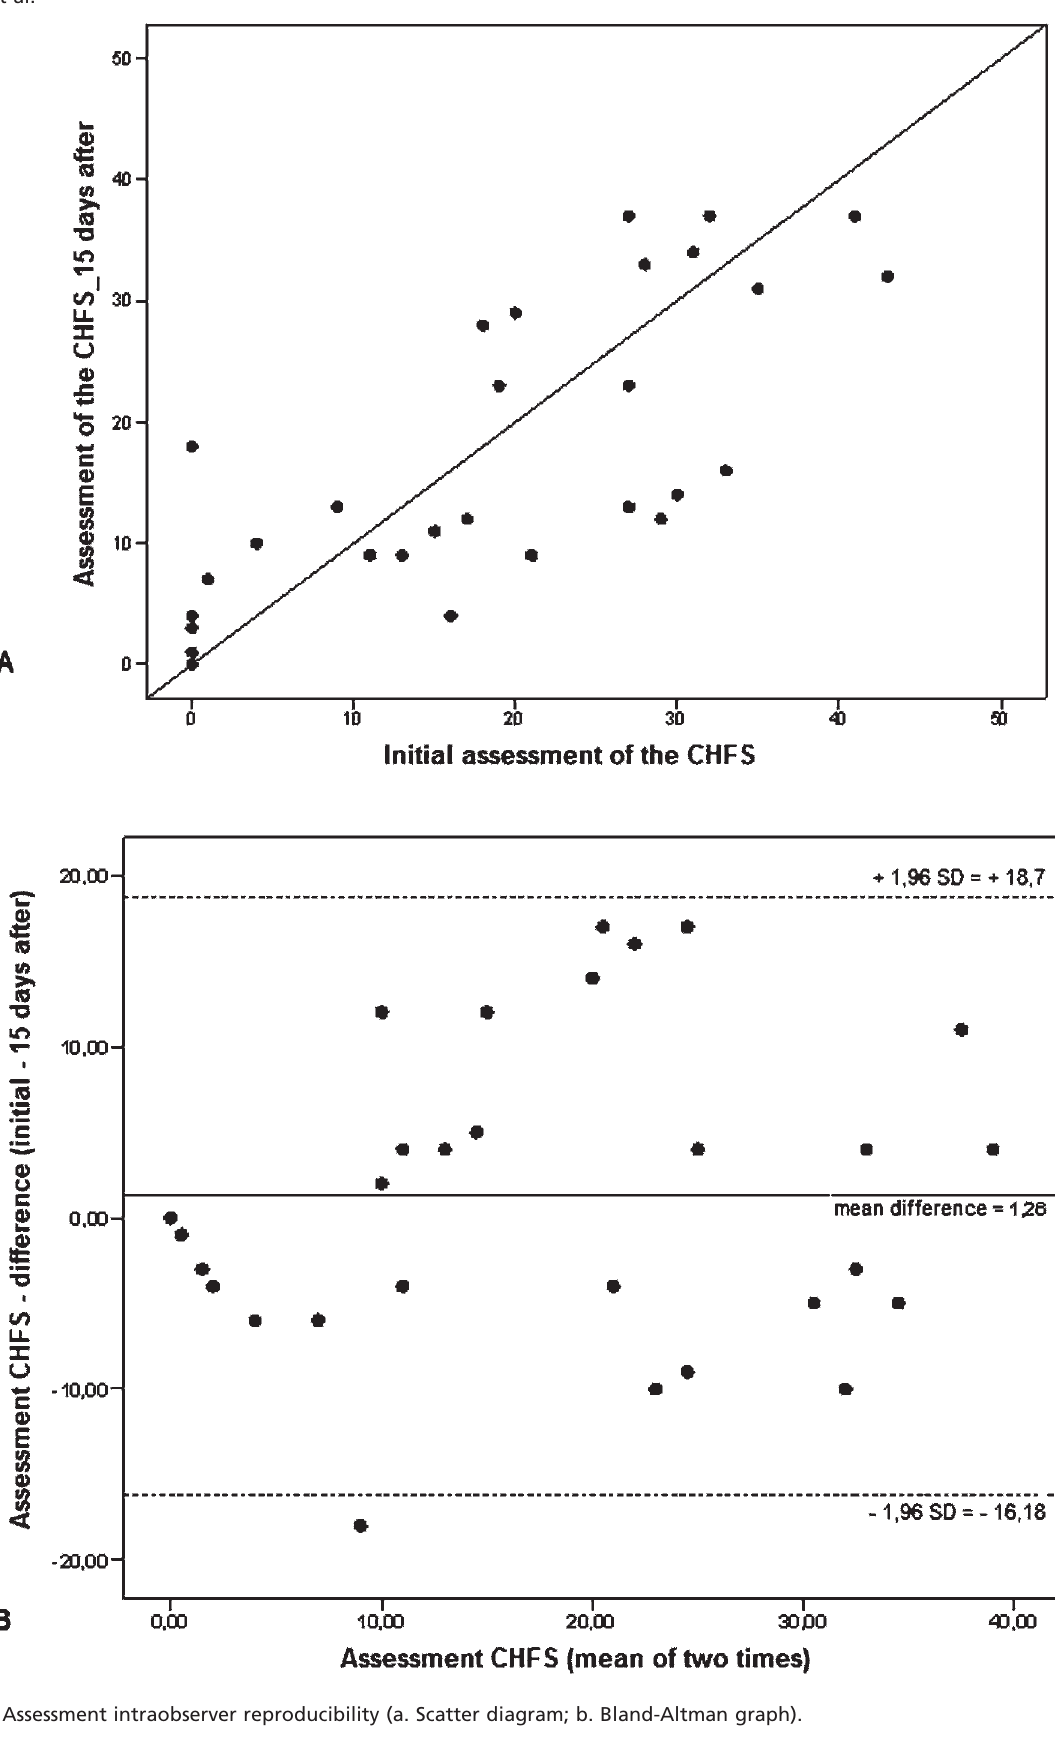
Figure 2 - Assessment intraobserver reproducibility (a. Scatter diagram; b. Bland-Altman